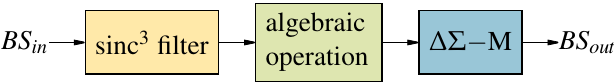
Figure 24. Multiplication of two bit-streams using logic operations.